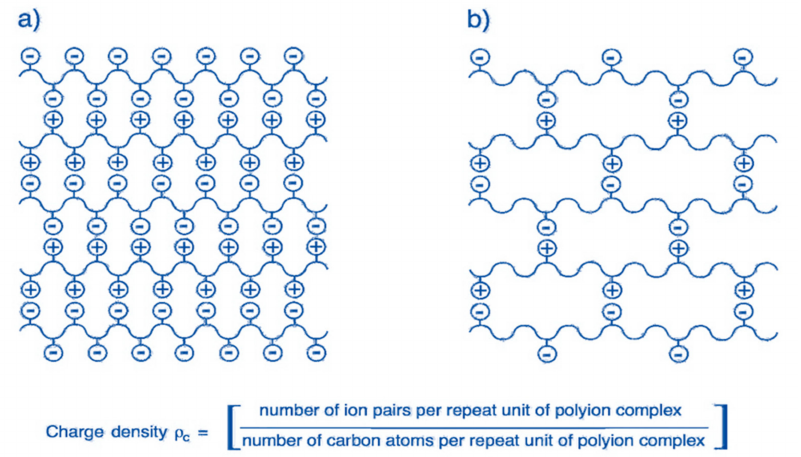
Figure 5. Simplified structure model of multilayered polyelectrolyte membrane of high ( a ) and low charge densities ( b ). The nanopores become larger and less hydrophilic as the charge density decreases. Possible chain interdigitation and incomplete neutralization are not considered. Reproduced with permission from Reference